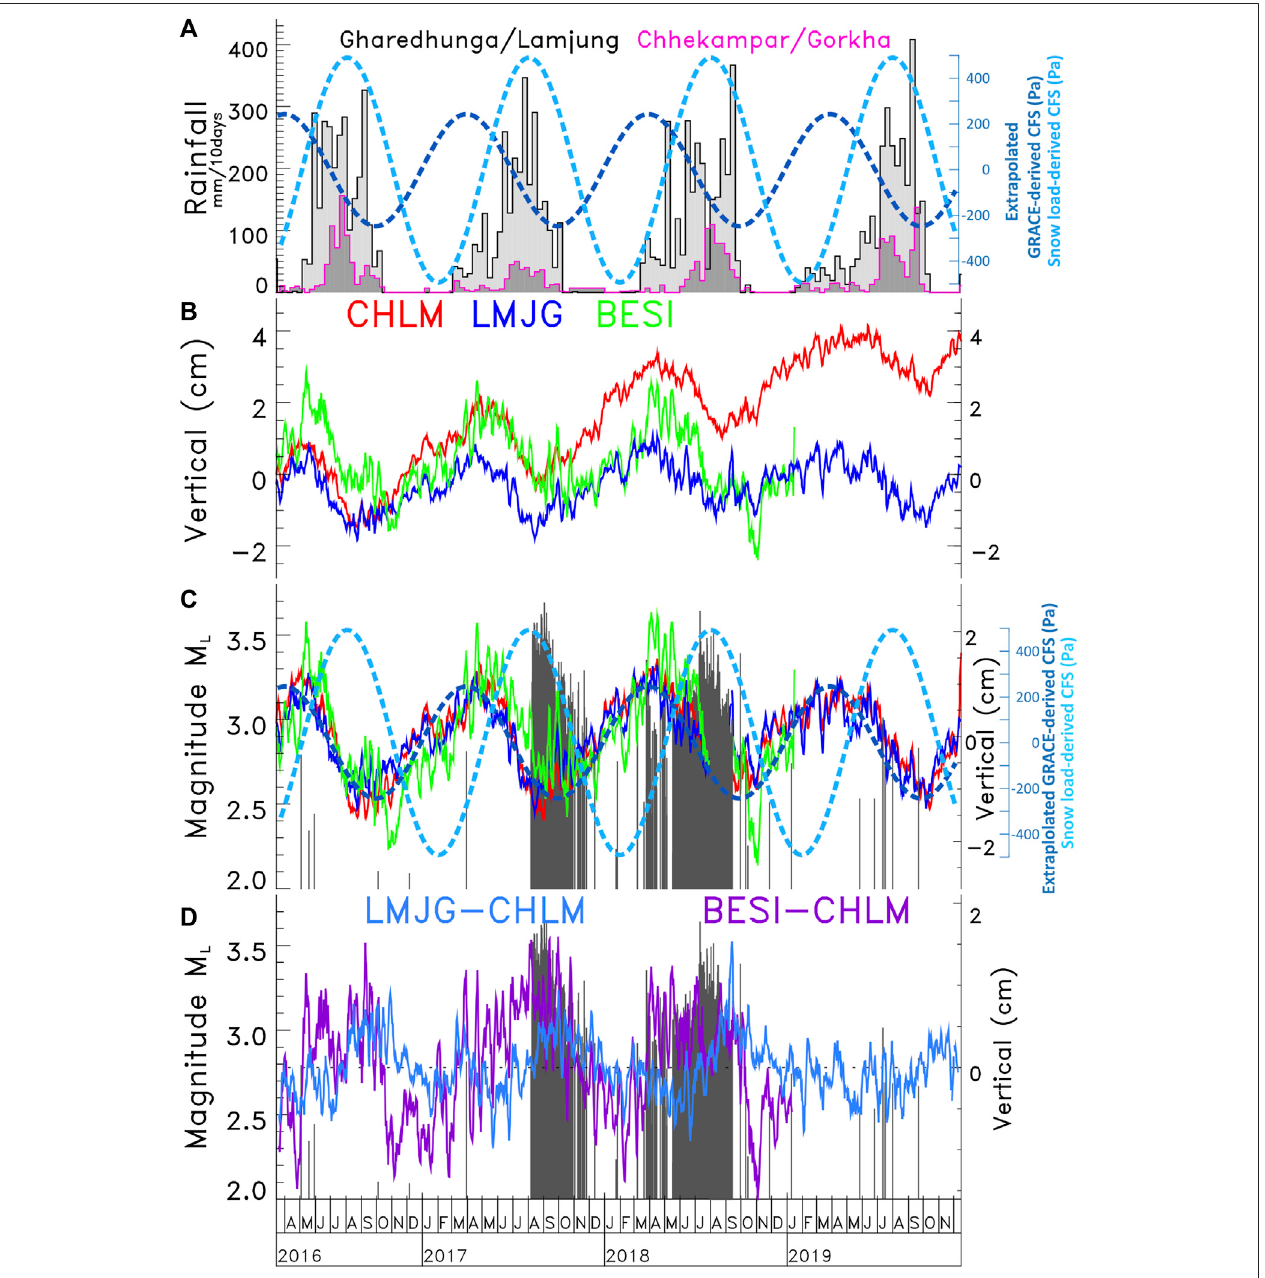
FIGURE5|(A) Pinkandblackhistogramsrepresenttherainfallmeasuredattwometeorologicalstations(ChhekamparandGharedhungalocatedin Figure1 ).The modulationoftheCoulombFailureStress(CFS),relatedtotheregionalstraining,isextrapolatedfromGRACE(darkblue),andthatrelatedtothelocalstraining,isderived from local snow loads (light blue) (B) Vertical displacements measured at the cGPS stations of Chilime (CHLM in red), Lamjung (LMJG in blue) and Besisahar (BESI in green) (C) Detrended vertical displacement confronted with the magnitude versus time distribution of the seismicity (in grey) and with (D) LMJG ‒ CHLM and BESI ‒ CHLM cGPS